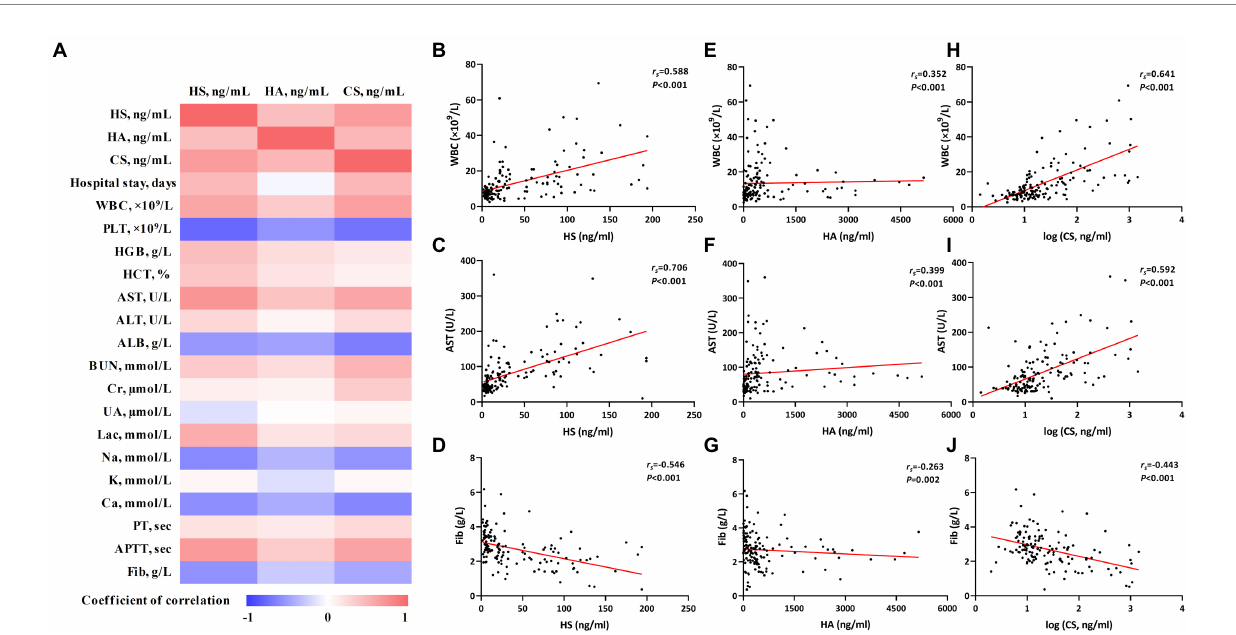
FIGURE 2 The correlations of heparan sulfate (HS), hyaluronic acid (HA), and chondroitin sulfate (CS) with conventional laboratory parameters. Correlations were calculated using Spearman rank correlation analysis. The correlation coefficients were represented by different shades of color in panel (A) ; the red and blue colors represent positive and negative correlations, respectively. The correlations of HS, HA, and CS with individual laboratory parameters [white blood cells (WBC), aspartate transaminase (AST), and Fib] are shown in panels (B) through (J)